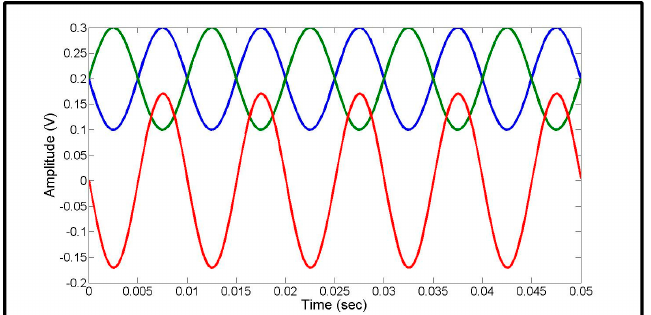
Figure 14. Transient response of the differential input and output.